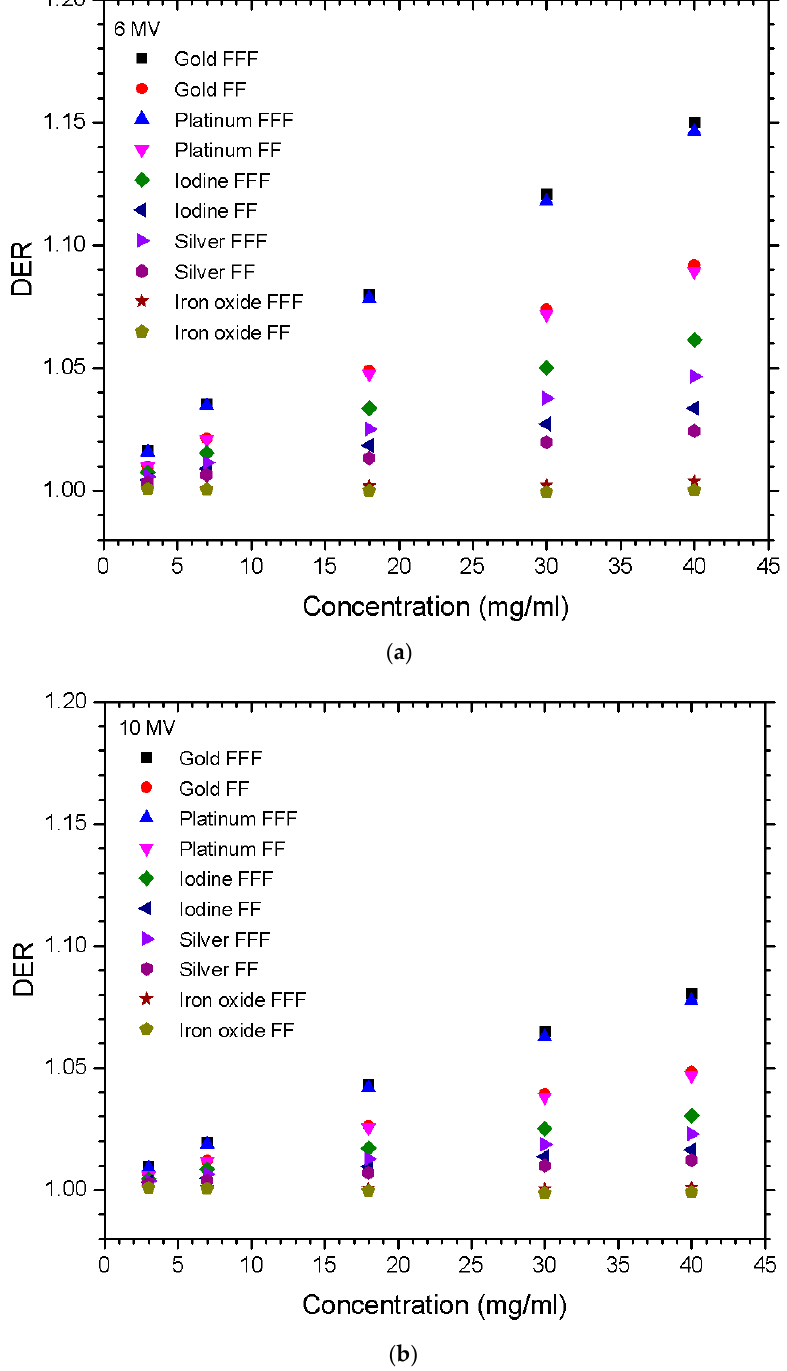
Figure 1. Relationships of the dose enhancement ratio (DER) and nanoparticle concentration vary with different materials using the ( a ) 6 MV and ( b ) 10 MV photon beams. Gold, platinum, iodine, silver, and iron oxide nanoparticles with concentrations equal to 3, 7, 18, 30, and 40 mg/ml were used. The DER was calculated as the ratio of the target dose with nanoparticle addition to the target dose without nanoparticle addition under the same simulation configuration.